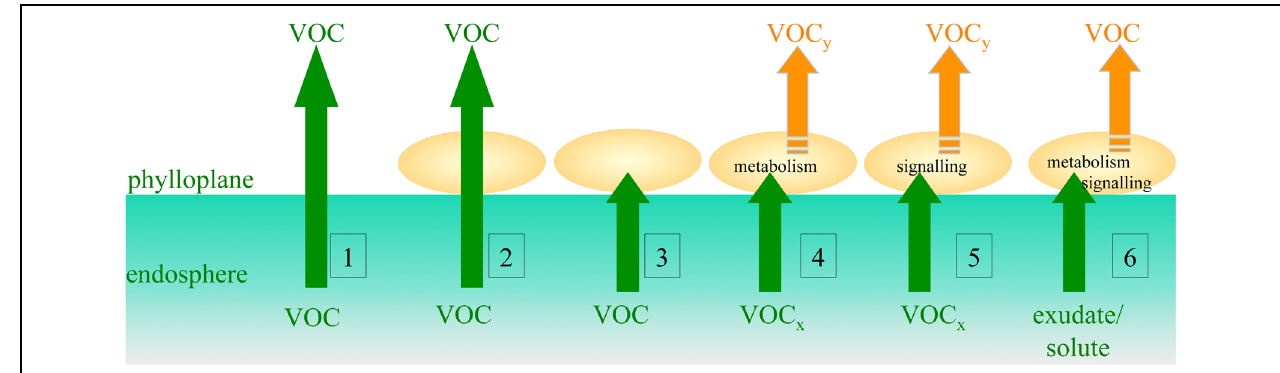
FIGURE 3 | Theoretical scenarios of the fate of phyllosphere-emitted volatile organic compounds (VOCs). Green and orange arrows respectively represent plant organic compound fluxes and VOCs fluxes generated from microbial epiphytes. (1) Free transfer through cuticle; (2) free transfer through cuticle and epiphytes; (3) interception by epiphytes via abiotic or metabolic processes with no VOC release; (4)